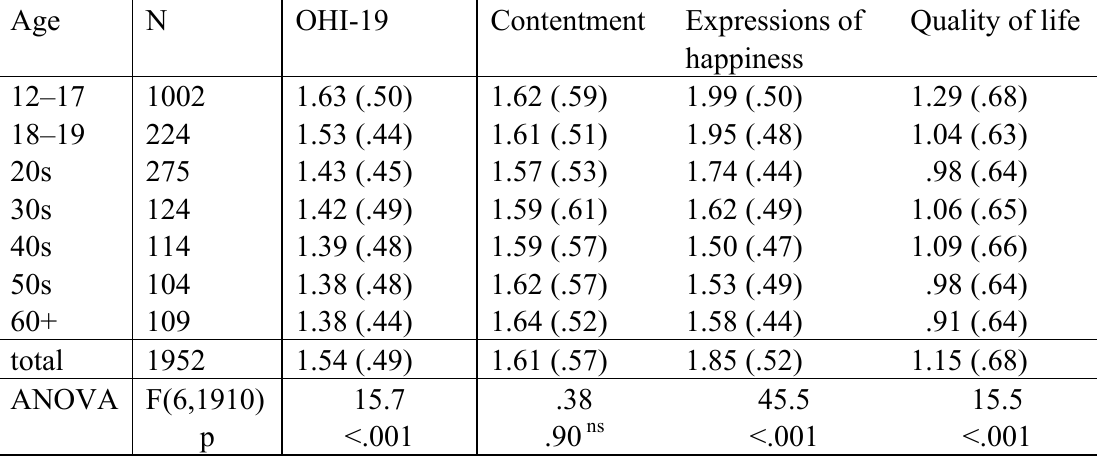
Table 3. Mean (SD) values & ANOVA (Analysis of Variance) of happiness scales by